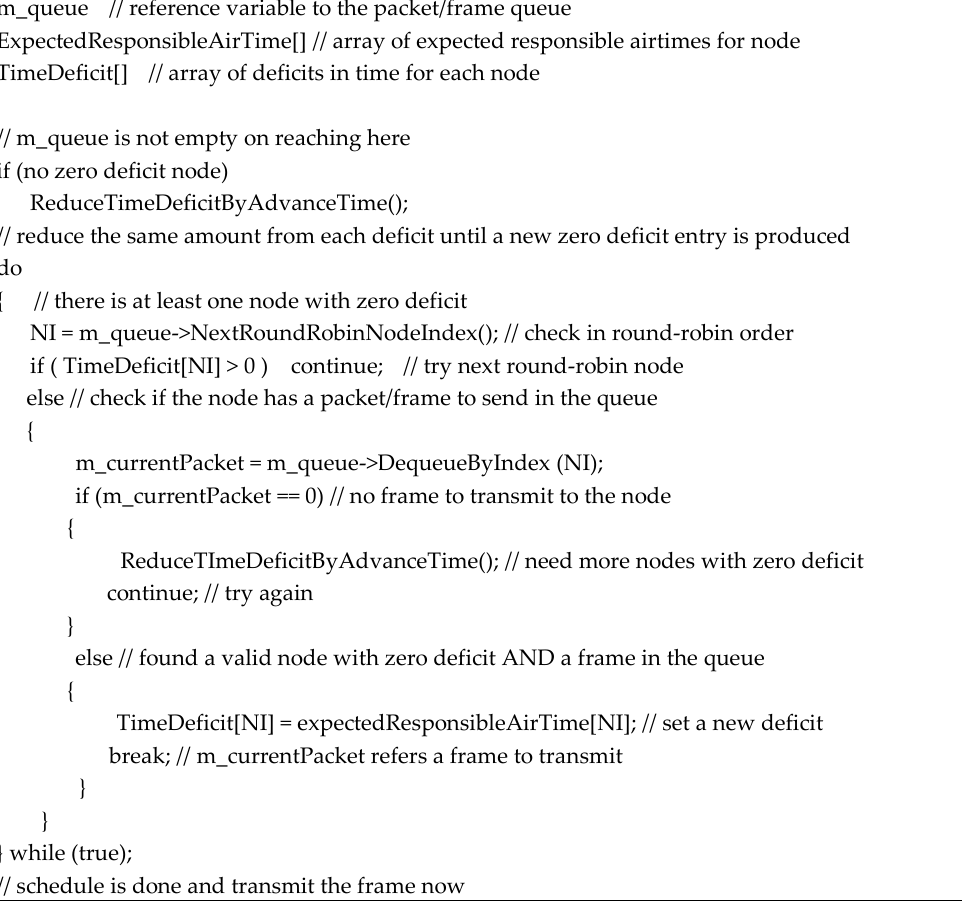
Figure 4. Basic Network Topology in Experiments.